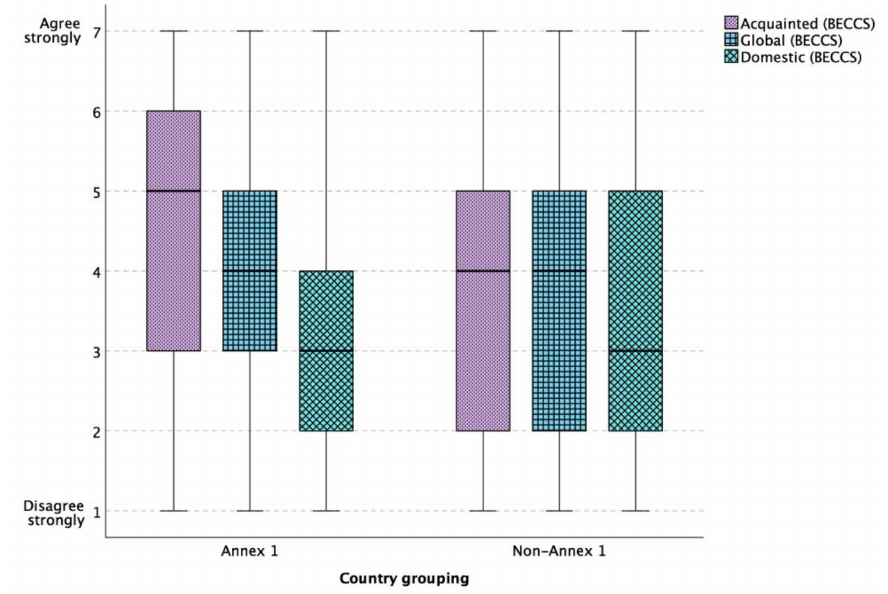
Figure 7. Self-assessed technical readiness and views on the deployment of BECCS to limit global temperature rise to 2 ◦ C through global deployment or deployment of BECCS in respondents’ country of